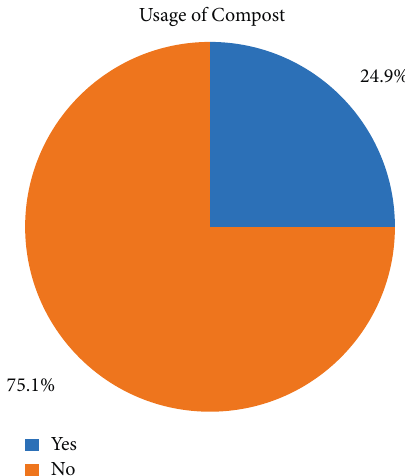
Figure 2: Pie chart for chemical coating of a seed.